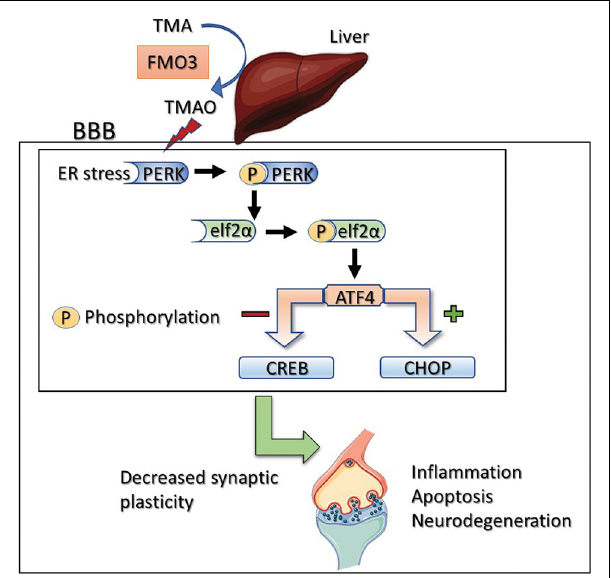
FIGURE 7 | Proposed mechanism of TMAO induced synaptic plasticity deficits. Activation of PERK by TMAO leads to phosphorylation of eIF2 α which can directly inhibit general protein synthesis (mRNA translation) or activate ATF4. ATF4 negatively regulates synaptic plasticity and memory by acting as a repressor of CRE-dependent transcription (CREB). Alternatively, ATF4 translocates to the nucleus and increases the expression of CHOP which promotes reactive oxygen species formation, inflammation, and